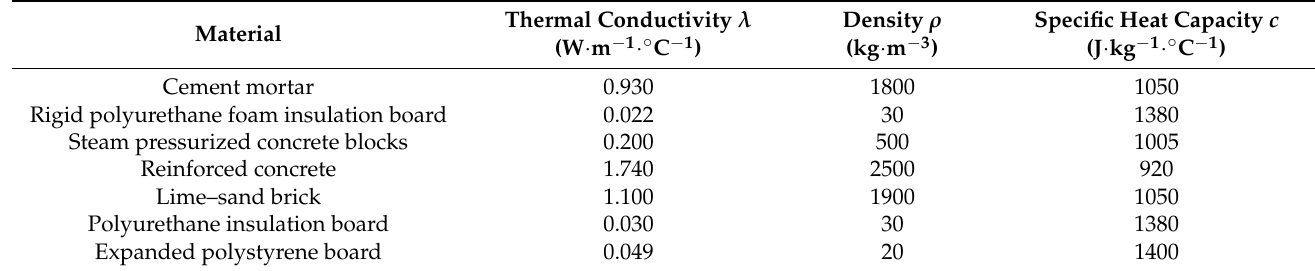
Table 1. Thermophysical properties of building materials.